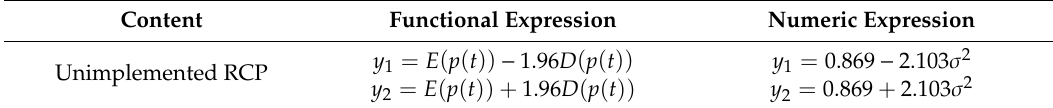
Table 3. The numerical expression of water pollution control e ff ect under the unimplemented